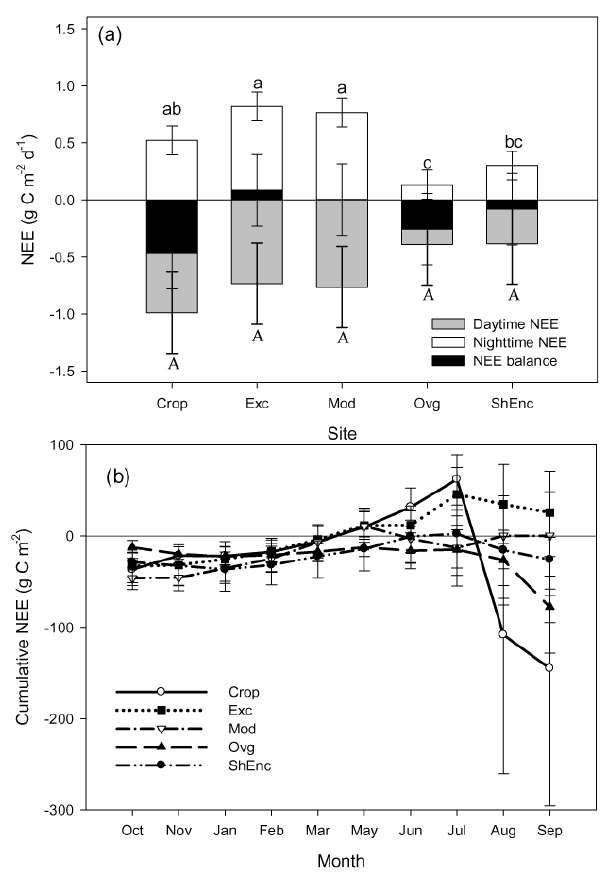
Fig. 4. (a) Average rates of net NEE (mean ± 1SE) in the short- grass steppe in central Mexico associated with five different land use types. Different letters on both the top and bottom of bars indi- cate significant differences among sites ( P < 0.05, capital letters in- dicate daytime differences, whereas lowercase letters refer to night- time differences in fluxes). (b) Cumulative NEE in the five sites, recorded from October 2008 to September 2009. Bars denote the combined standard uncertainty for each cumulative NEE. For ex- planation of acronyms, refer to Fig.